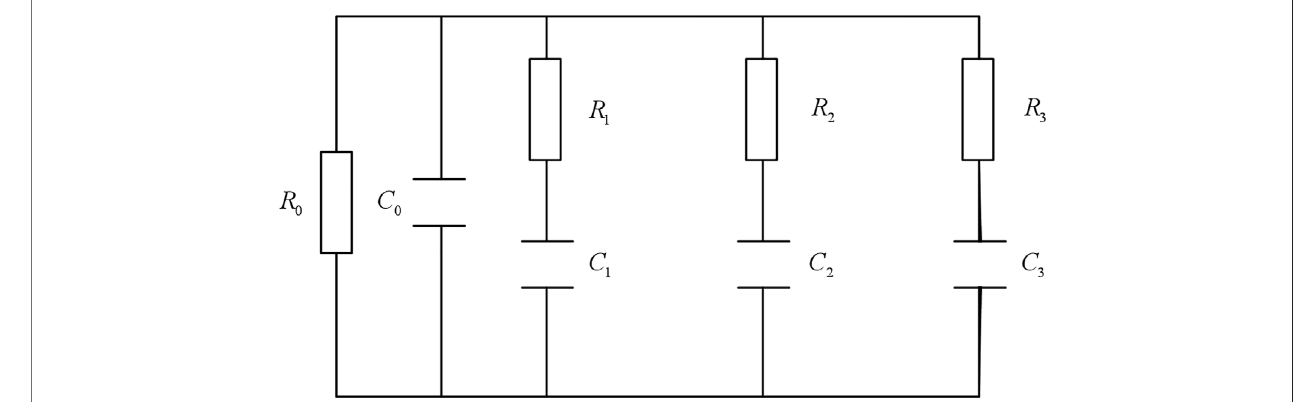
FIGURE 1 | Extended Debye model.